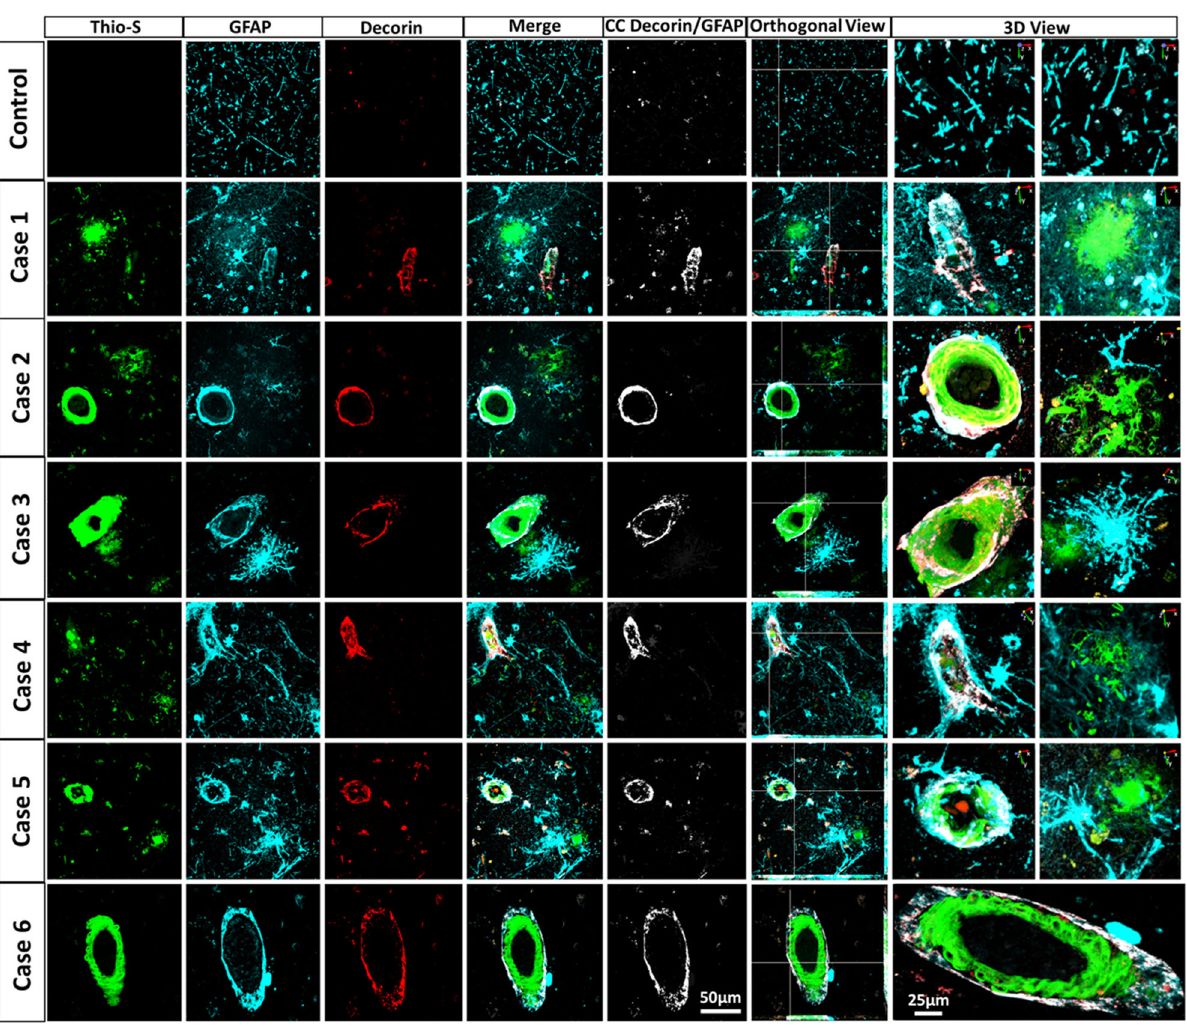
Fig. 7 Decorin + astrocytes are associated with vascular amyloid in AD/CAA patients. Triple immuno fl uorescence for amyloid (Thio-S, green), astrocytes (GFAP, Cyan) and Decorin (red) in AD/CAA and healthy control patients show Decorin + staining associated with vascular amyloid but not parenchymal amyloid deposits. Thio-S, GFAP and Decorin immunoreactivity overlay (Merge). Colocalization analysis (CC) was performed to determine pixel intensity correlation between Decorin and GFAP. White pixels indicate colocalization between Decorin and GFAP signal. The right panel shows orthogonal images and reconstructed three-dimensional views. Scale bar 25 or 50 μ m,